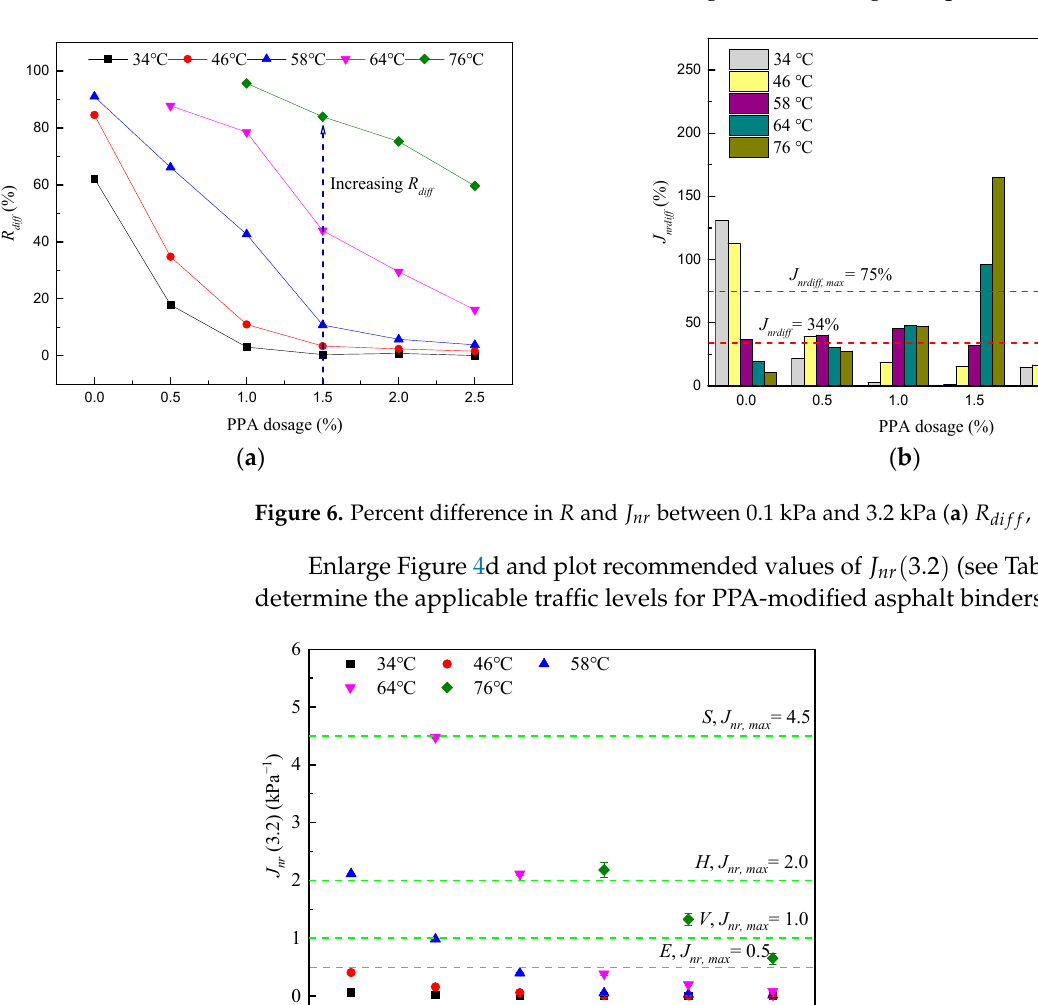
Figure 5. Comparison of 𝐽 (cid:3041)(cid:3045) (3.2) and 𝑅(3.2) to assess elastic response.